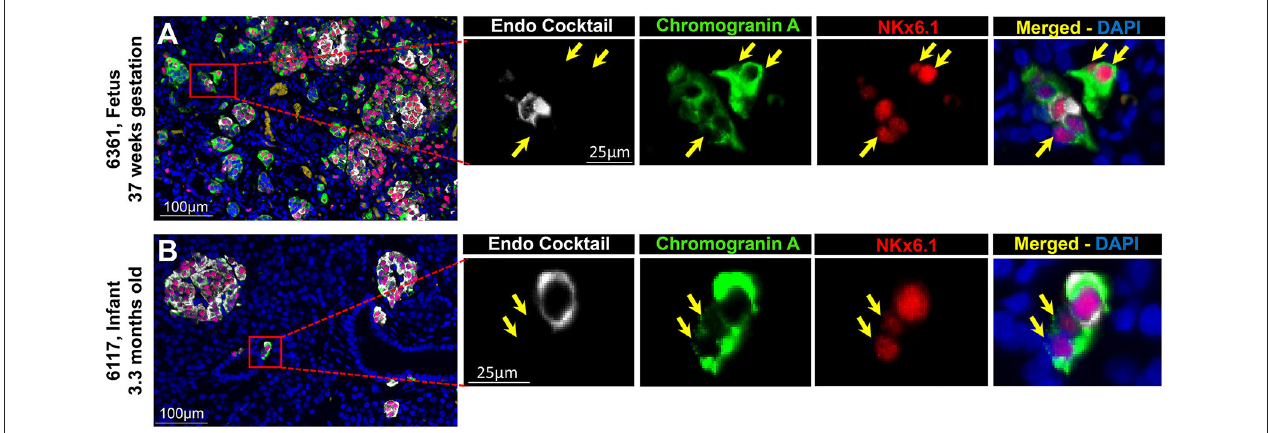
FIGURE 3 | ChromograninA positive hormone-negative (CPHN) cells express the endocrine differentiation transcription factor NKX6.1 in both fetal and infant pancreas. Representative pancreatic sections from fetal (A) and infant (B) donors immunostained for Endocrine cocktail (insulin, glucagon, somatostatin, pancreatic polypeptide, and ghrelin) (white), chromograninA (green), the transcription factor NKX6.1 (red) and DAPI (blue). Yellow arrows indicate CPHN cells. Scale bars: 100 µ m for low power and 25 µ m for high magnification images.